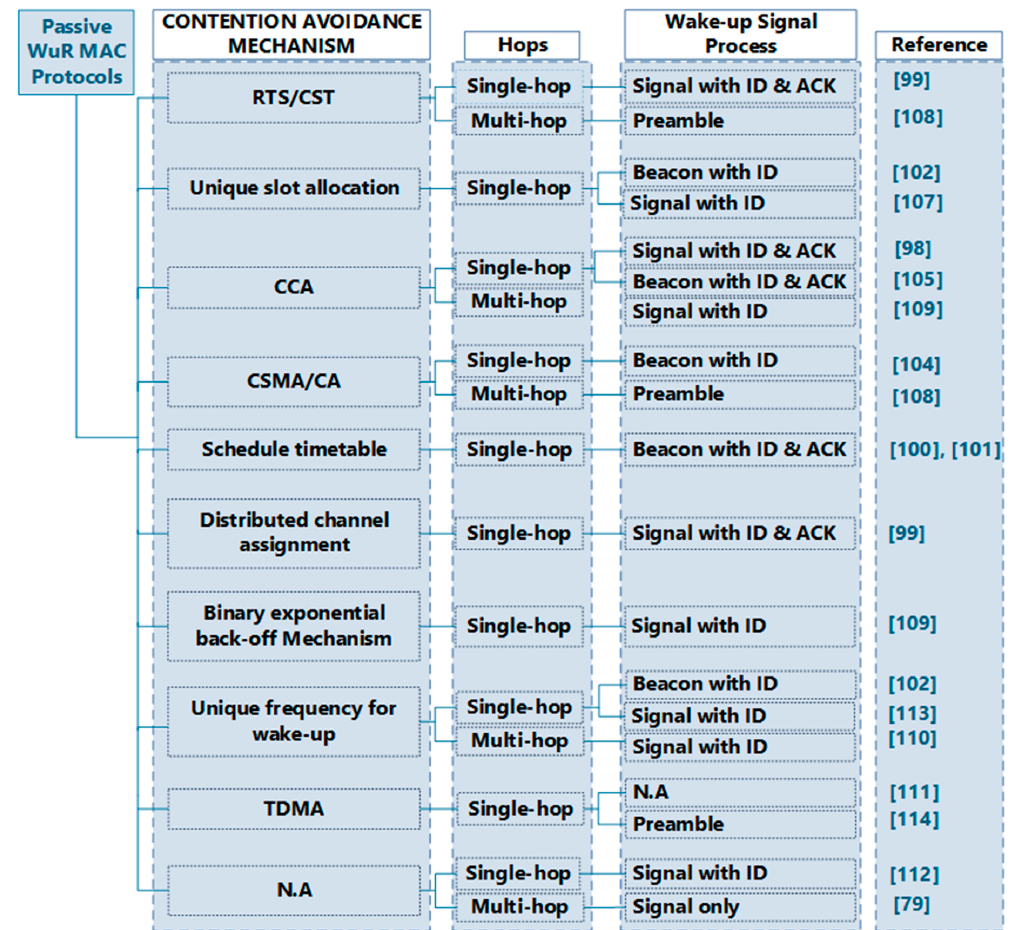
Figure 8. Classification of the previous works on passive wake-up radio MAC protocols.